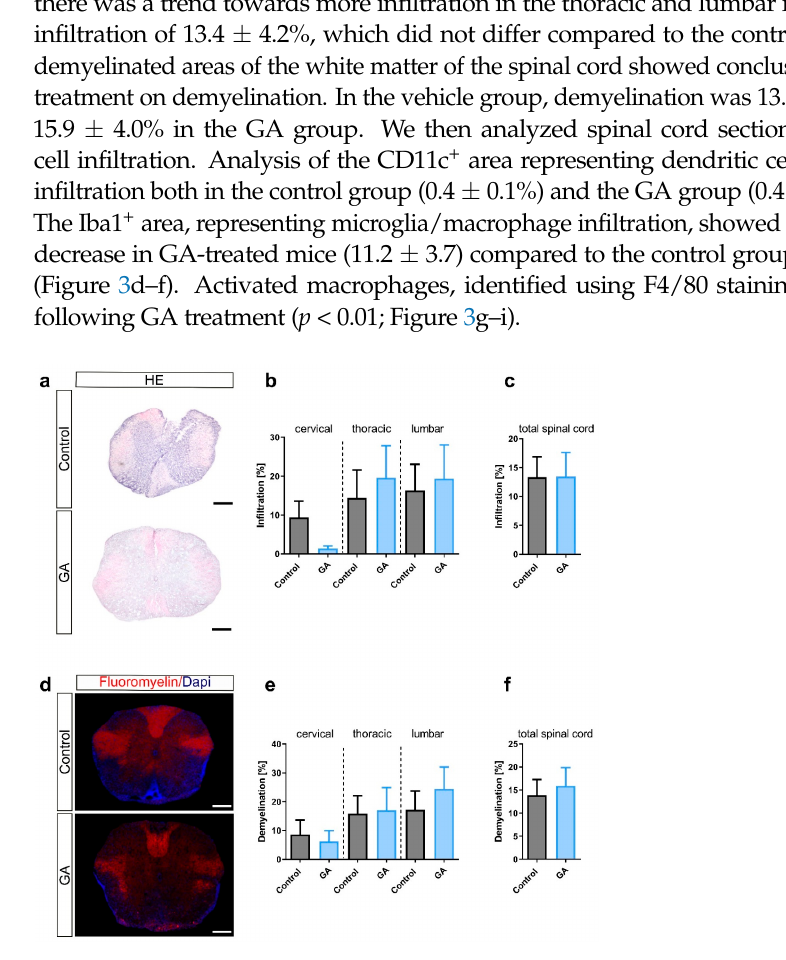
Figure 2. GA treatment has no effect on infiltration and demyelination in the spinal cord. ( a – d ) Infiltration was detected via HE staining, ( d – f ) demyelination via Fluoromyelin Red. Control mice had infiltration in 13.4% of the white matter of the spinal cord, as shown in representative transversal spinal cord sections. ( a ) Cervical, thoracic and lumbar sections of the spinal cord were analyzed separately and showed no changes of general infiltration upon GA treatment ( b ) as well as analysis of all segments combined ( c ). ( d ) Representative images of Fluromyelin-stained spinal cord cryosections. Accordingly, demyelination did not differ neither in cervical, thoracic and lumbar sections ( e ) nor upon analysis of all segments in combination ( f ). Data were analyzed using one-way ANOVA ( b , e ) or non-parametric Kruskal–Wallis test ( c , f ). Data are shown as mean ± SEM. Scale bars depict 50 µm.